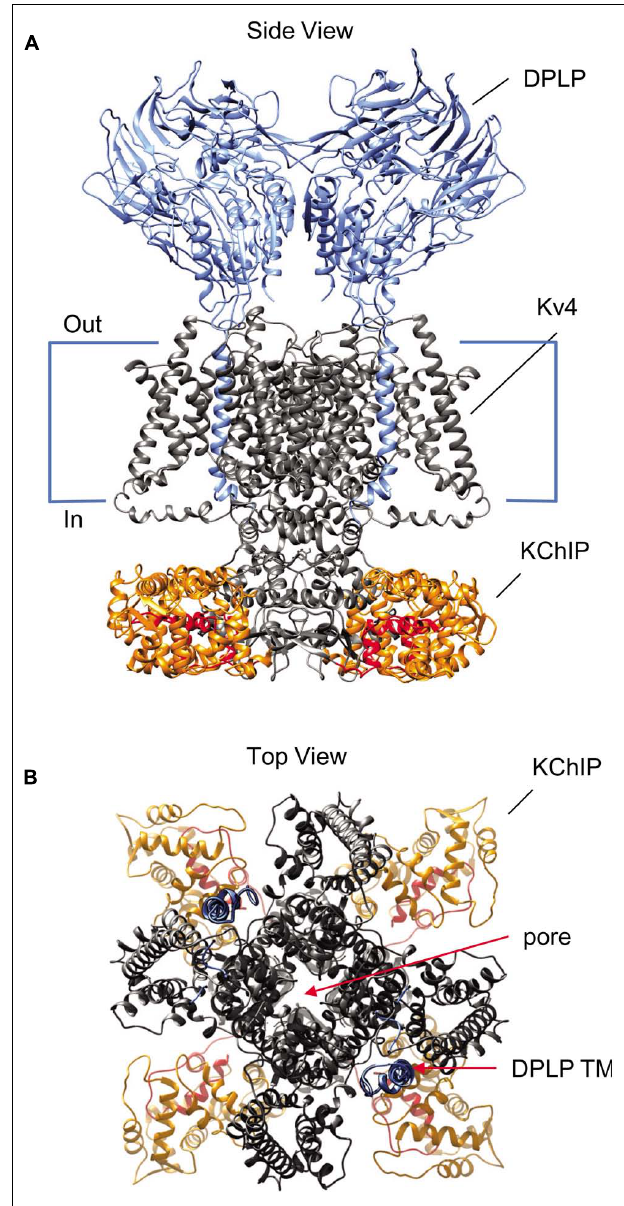
FIGURE 1 | Structural model of the Kv4-KChIP-DPLP supermolecular complex. The structure of the KChIP1-Kv4.3T1 complex from Pioletti etal. (2006) was docked with the Kv1.2 structure from Long etal. (2007).The structure of DPP6 dimer from Strop etal. (2004) is positioned so that the transmembrane segments are near the voltage-sensing domains of the channel core domains.The structure depicts only two DPP6 molecules, while the experimental evidence suggests that complete complex contains four DPLP subunits (Soh and Goldstein, 2008). (A) Side view of the multi-protein channel complex. Kv4 pore-forming subunit is shown in gray, with the exception of the pre-T1 N-terminal domain which is shown in red. The KChIP molecules are shown in orange; the DPLP molecules, blue.This view clearly shows that KChIP binding sequesters the Kv4 N-terminus. (B) Top view of the complex as seen from the extracellular side.The central pore generated by the Kv4 subunits is indicated and can be easily observed. Note the KChIP molecules (orange) and the DPLP transmembrane domains (TM, blue) reside between the Kv4 voltage sensors with free access to theT1 side